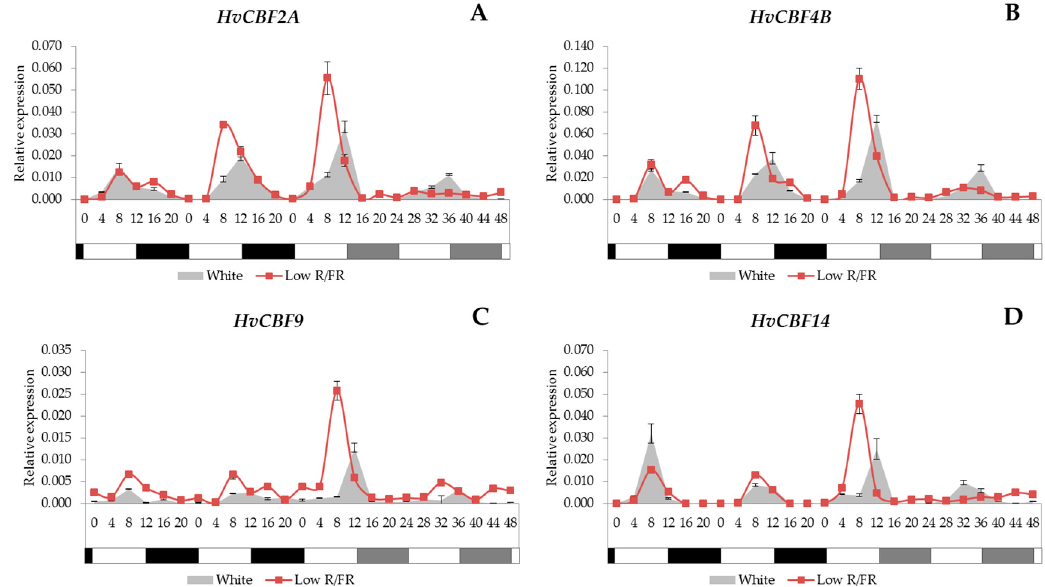
Figure 5. Gene expression levels in HvCBF2A , HvCBF4B , HvCBF9 and HvCBF14 ( A – D ) with white light and low R/FR illumination. Conditions are the same as in Figure 1.